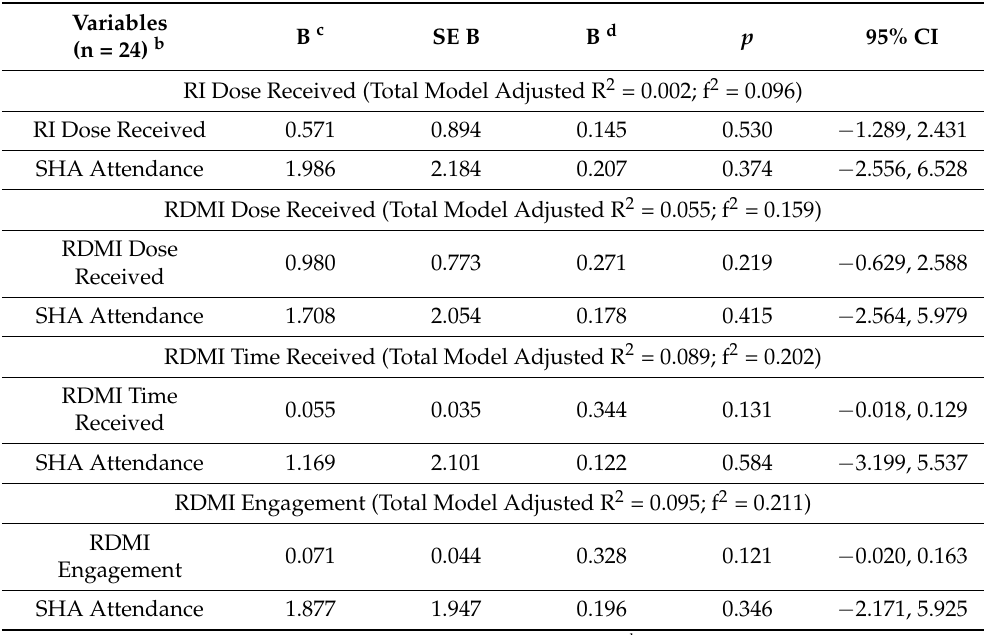
Table 2. Multiple Linear Regression for Measures of RDMI Use, Summer Harvest Adventure Atten- dance, and Changes in PAC Diet Quality a .